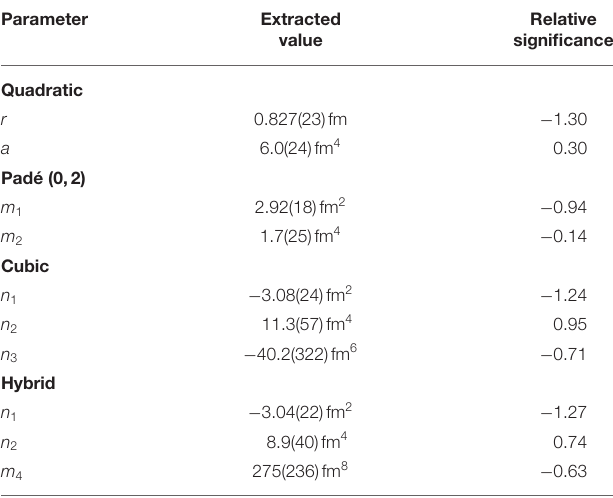
Frontiers in Physics |